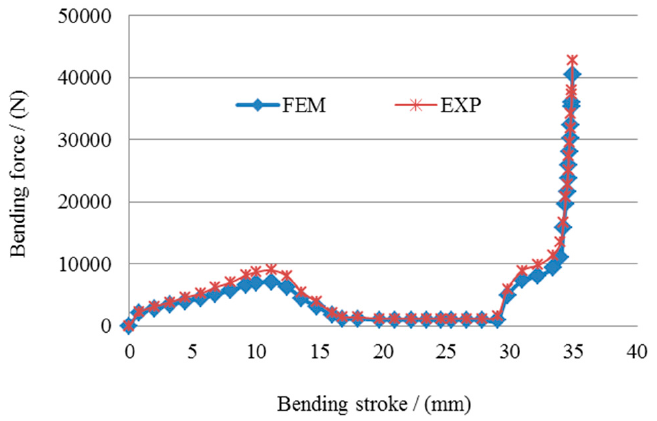
Figure 16. Comparison of bending forces between FEM simulations and experimental results ( θ : 90°, t : 3 mm, WP L : 130 mm, W : 60 mm, R p : 5 mm, R ud : 5 mm, without pad). EXP: Experiment.